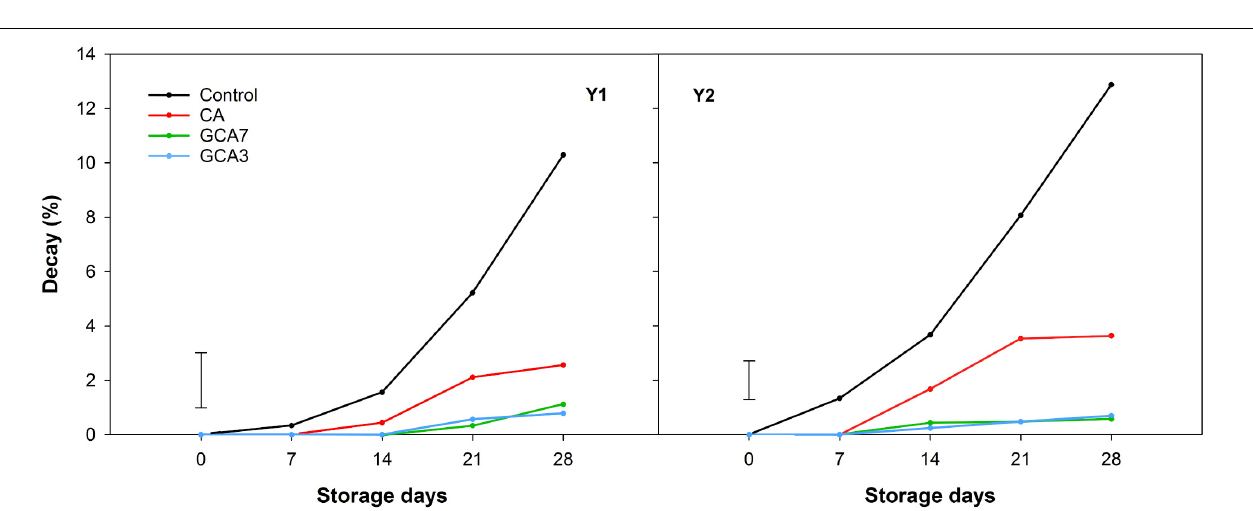
FIGURE 2 | Real-time respiration rate (CO 2 production expressed as mg kg − 1 h − 1 ) of “Duke” blueberry fruit subjected to controlled atmosphere (CA) applications throughout 28 days of storage at 0 ◦ C and 90–95 RH%; air [control]; standard CA (10 kPa CO 2 + 5 kPa O 2 ); graduated CA 7 (GCA7; 7 days to achieve standard CA values); and GCA3 (3 days to achieve standard CA values). Two consecutive seasons are considered 2017 (year 1; Y1) and 2018 (Y2). Lines represent smooth fit curves.